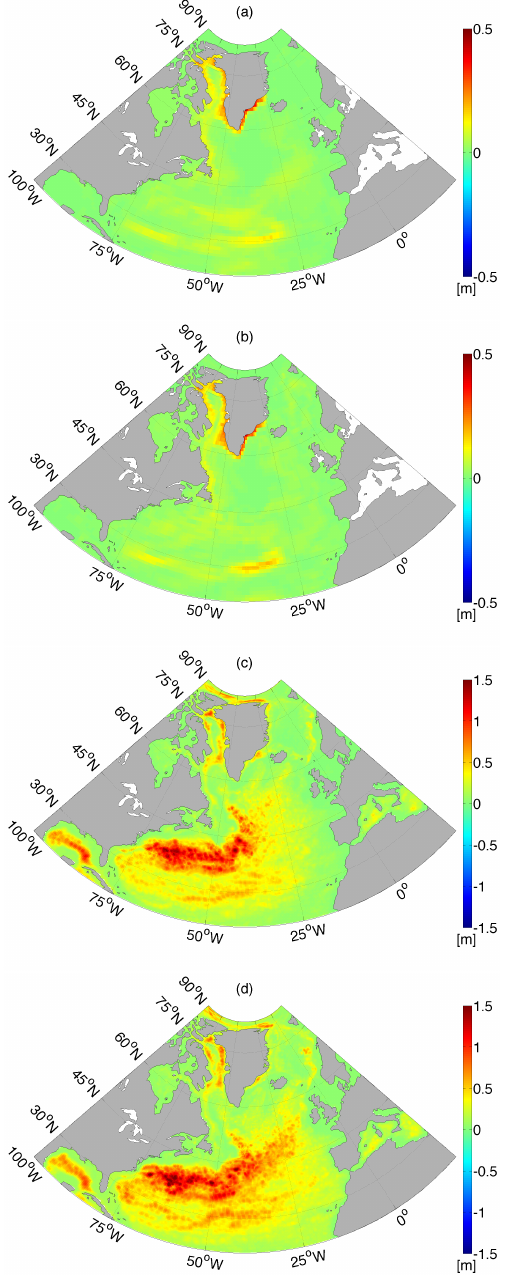
Figure 3. Maximum of monthly SSHP (hosing − control) 0.5Sv GrIS perturbation of the first 10 (a, c) and last 10 (b, d) model years, Fig. 3. (a) Maximum of monthly SSHP (hosing - control) 0.5 Sv GrIS perturbation of the first 10 (a,c) and last for the LR (a, b) and HR (c, d) model simulations. Figure 4. Average return period for a 0.05m anomaly (SSHP (hos- 10 model years (b,d) for the LR (a,b) and HR (c,d) model simulations. ing − control) for the 0.5Sv LR simulation) of the first (a) and last 16 Fig. 4. Average return period for a 0.05m anomaly (SSHP (hosing - control) for the 0.5 Sv LR simulation) of (b) 10 years, and average return period for a 0.1m anomaly (SSHP (hosing − control) 0.5Sv HR simulation) of the first (c) and last the first (a) and last (b) 10 years, and average return period for a 0.1m anomaly (SSHP (hosing - control) 0.5 (d) 10 years. In the white areas the specific anomaly has not been Sv HR simulation) of the first (c) and last (d) 10 years. In the white areas the specific anomaly has not been 17 reached during the time reached during the time period.